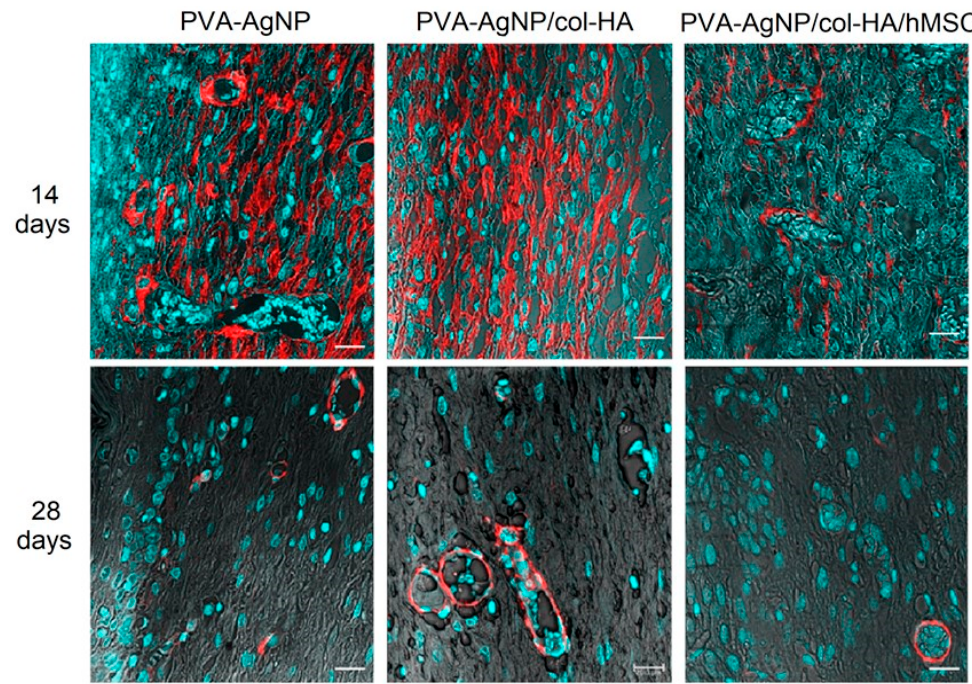
Figure 10. LSCM histology sections of the skin wound healing immunolabeled for α -SMA (red). Both myofibroblasts and microcirculation vessels can be distinctly identified. The cell nuclei are identified by DAPI (blue). Loose stromal tissue is observed by the PMT-TRANS mode (grayscale contrast structures). Bars 10µm.